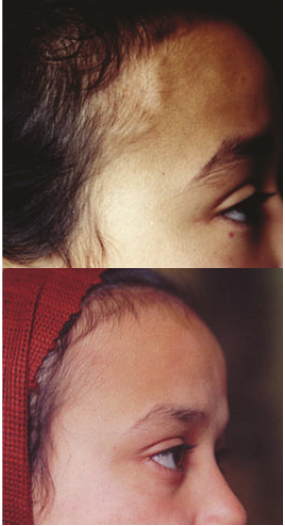
Figure 1: Above: patient’s photograph before treatment. The right superficial temporal artery shows dilatation along its course, nodu- lar in some parts. The red papules seen on the forehead and below her right eye are due to insect (mosquito) bites. Below: patient’s photograph after treatment. It shows complete disappearance of the right superficial temporal artery